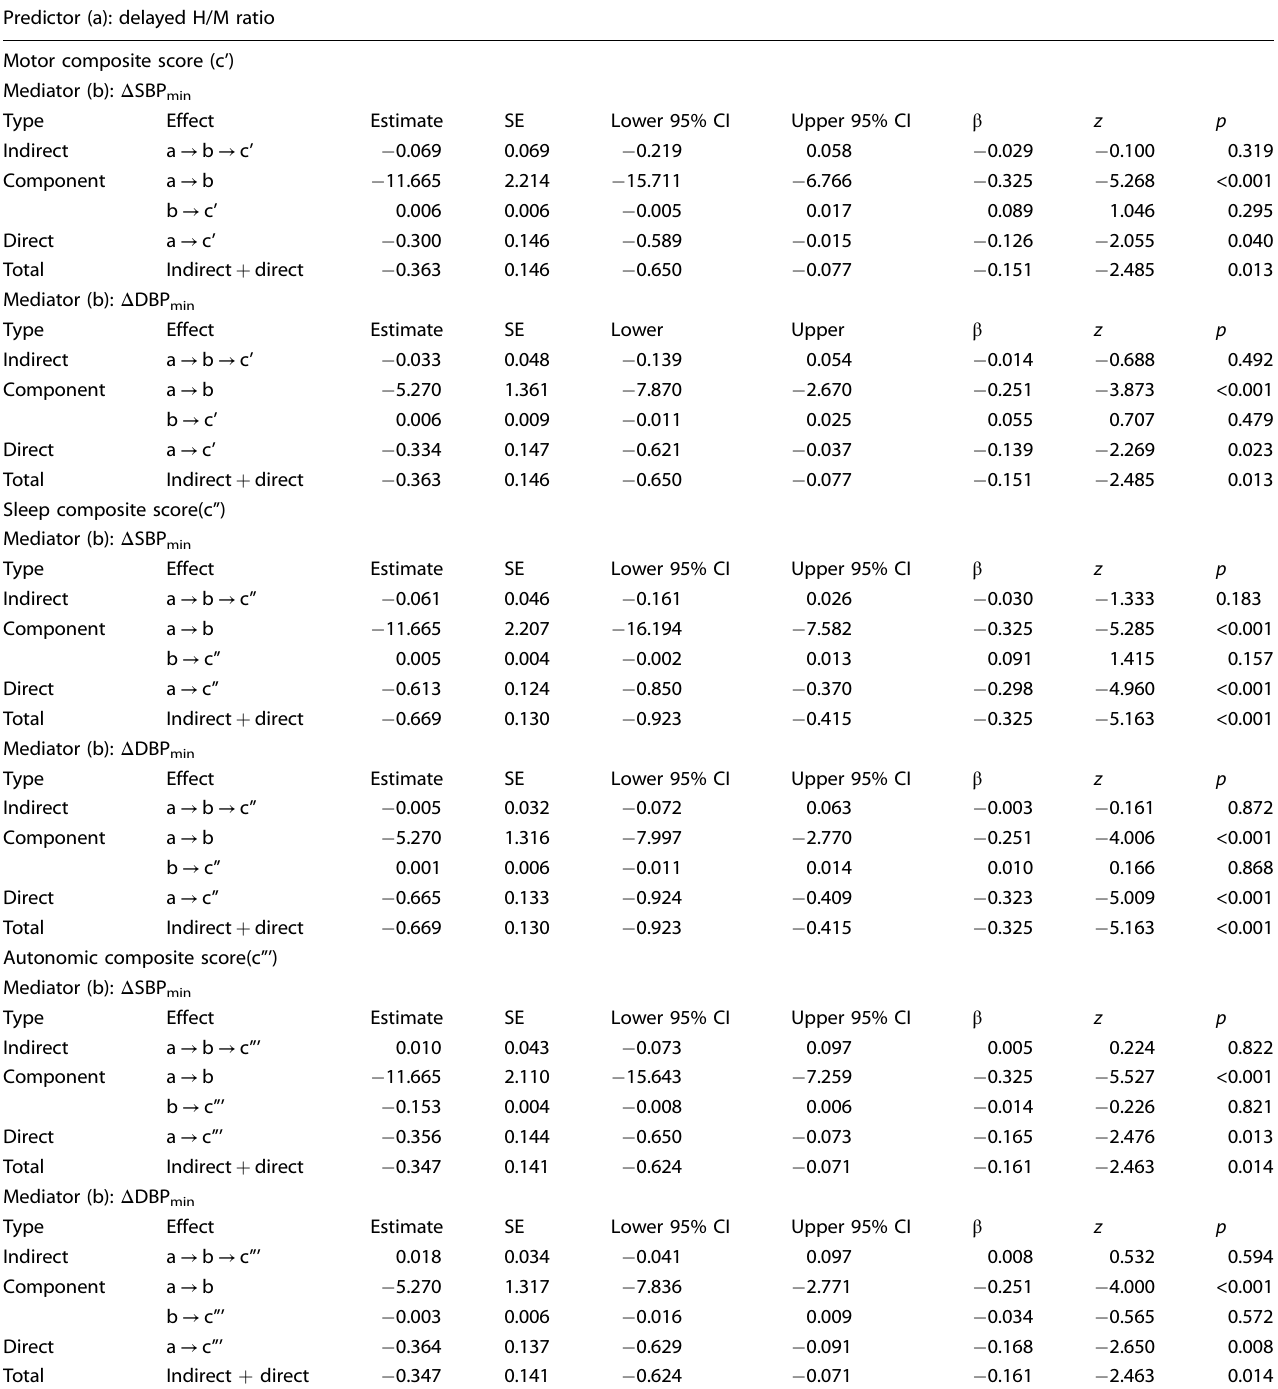
Table 3. The mediating effects of orthostatic blood pressure changes ( Δ SBP min , Δ DBP min ) on subdomain composite